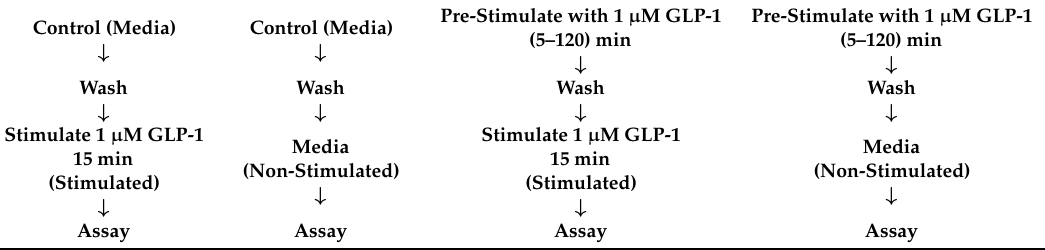
Table 1. Schematic representation of the desensitization